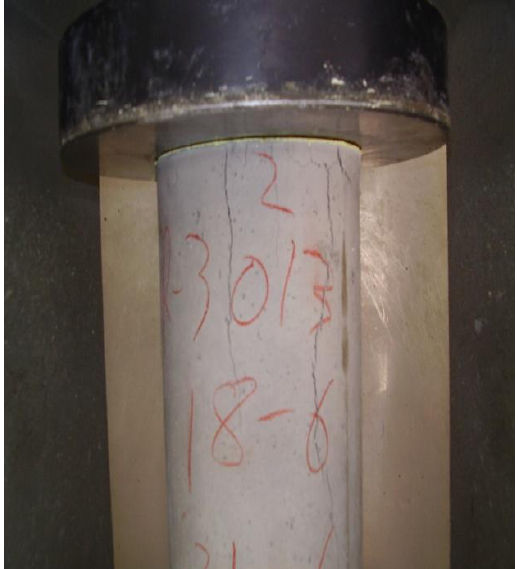
Figure 7. State of cracking of the sample with 10% of PCM during the